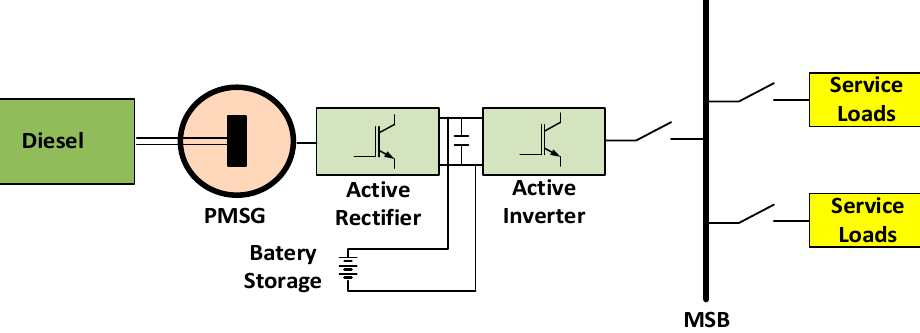
Figure 1. Typical autonomous hybrid power plant system with the PMSG in series topology.